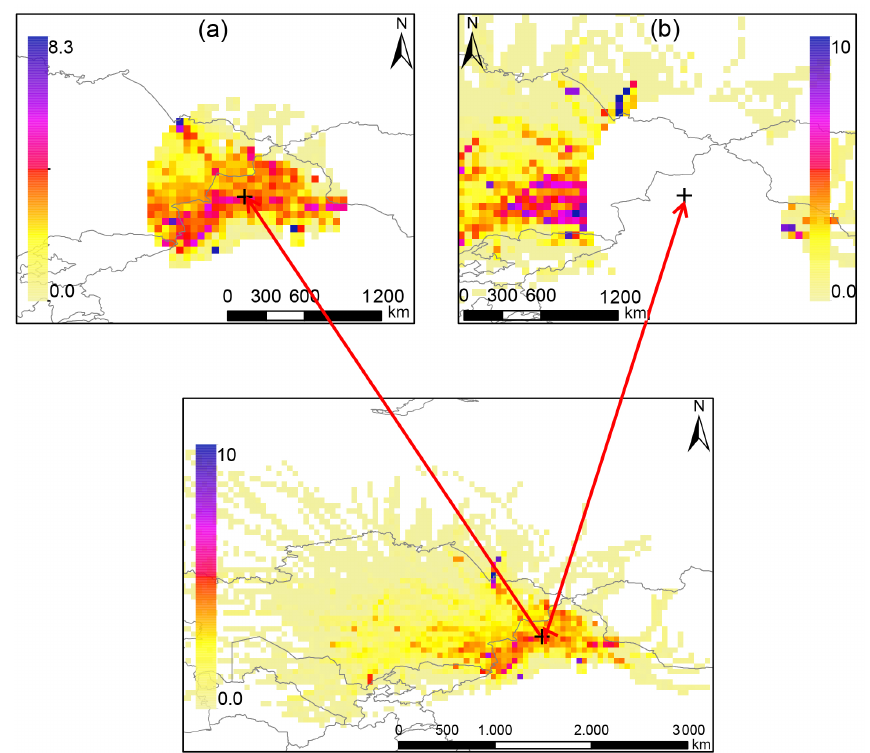
Figure C2. Example of (a) local area and (b) domain of regional transport range extracted by a circle with a radius of 7 ◦ . The black cross represents the sampling point and is set as the original